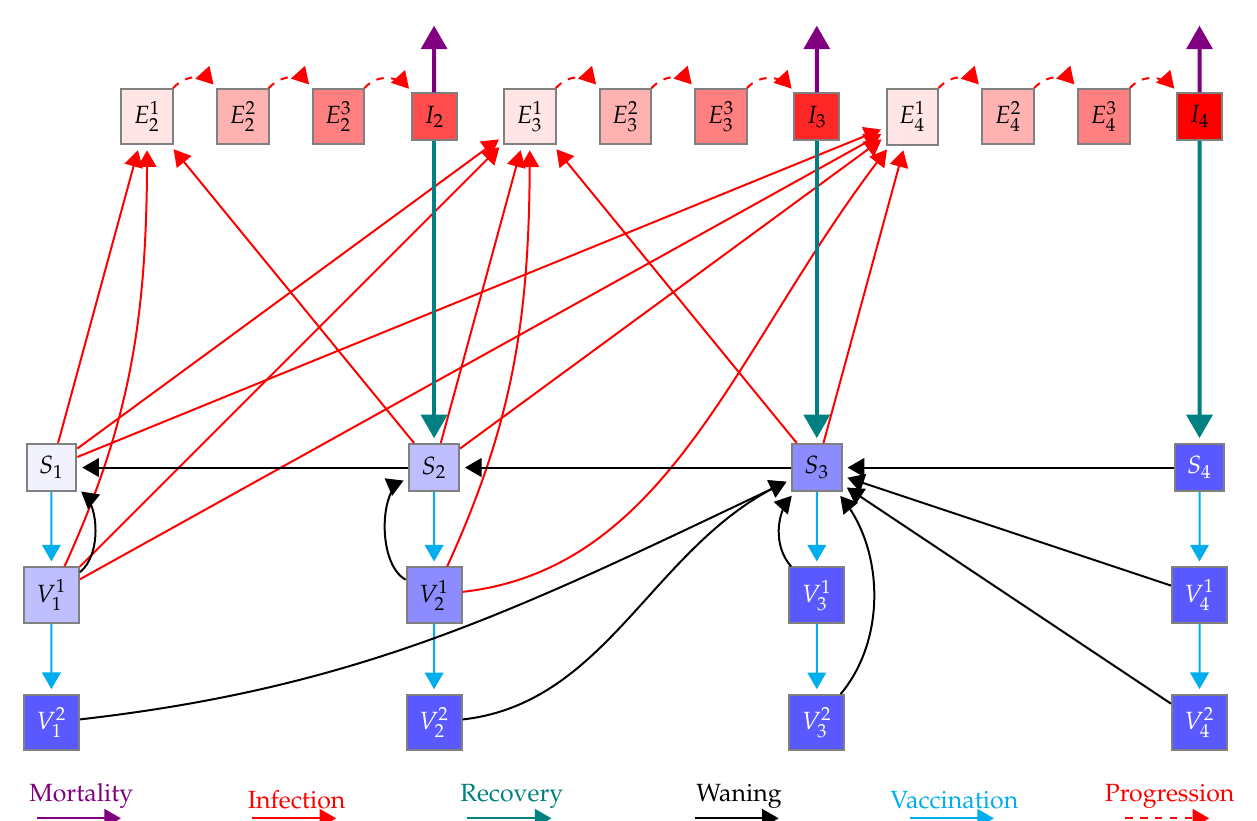
Figure 1. Schematic of the model for one age group. Here, S 1 , S 2 , S 3 , and S 4 (purple shaded boxes) represent susceptible individuals who are immunologically naive, have some, moderate, and full immunity, respectively. I 2 , I 3 , and I 4 (red boxes) represent infected individuals with mild, moderate and severe symptoms, respectively, who will develop some, moderate, and full immunity once ( i = 1,2,3,4, j = 1,2 ) represent vaccinated individuals recovered (teal solid line), respectively. V j i from the S i classes ( i = 1,2,3,4) after j = 1,2 doses of vaccine given a two-dose schedule. E k i ( i = 2,3,4; k = 1,2,3 ) represent exposed individuals (infected, asymptomatic, not infectious) with progressive stages k = 2,3,4 that will experience mild I 2 , moderate I 3 , and severe I 4 symptoms. Susceptible and vaccinated individuals can be infected and move to the exposed classes (red lines). Susceptible and vaccinated classes at the same location on the immunity continuum have similar characteristics. Immunity gained from infection and vaccination can wane (black lines). The bottom of the figure lists all the